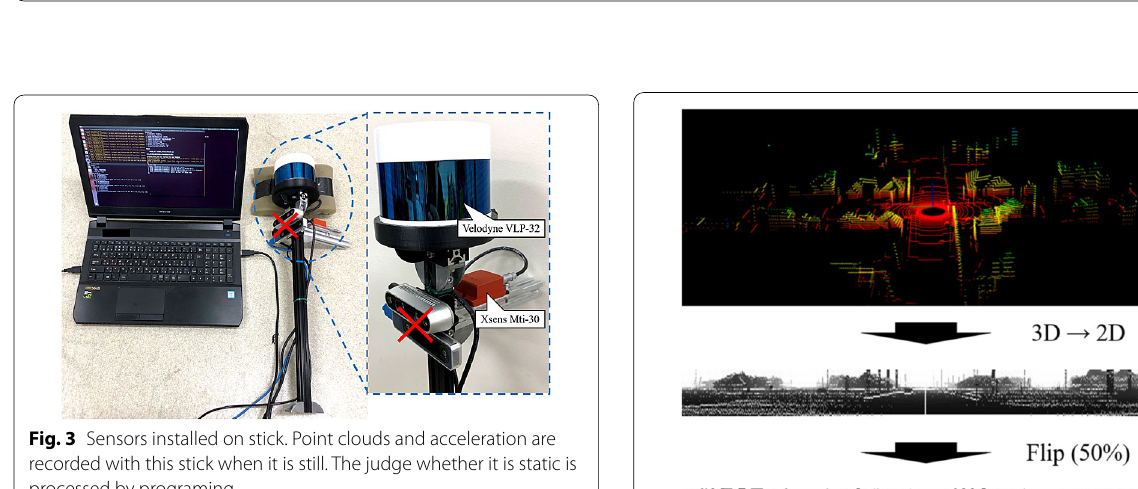
Fig. 2 Examples of datasets. The datasets consist of depth images and corresponded gravity vectors g [ m ∕ s 2 ] in the robot frame